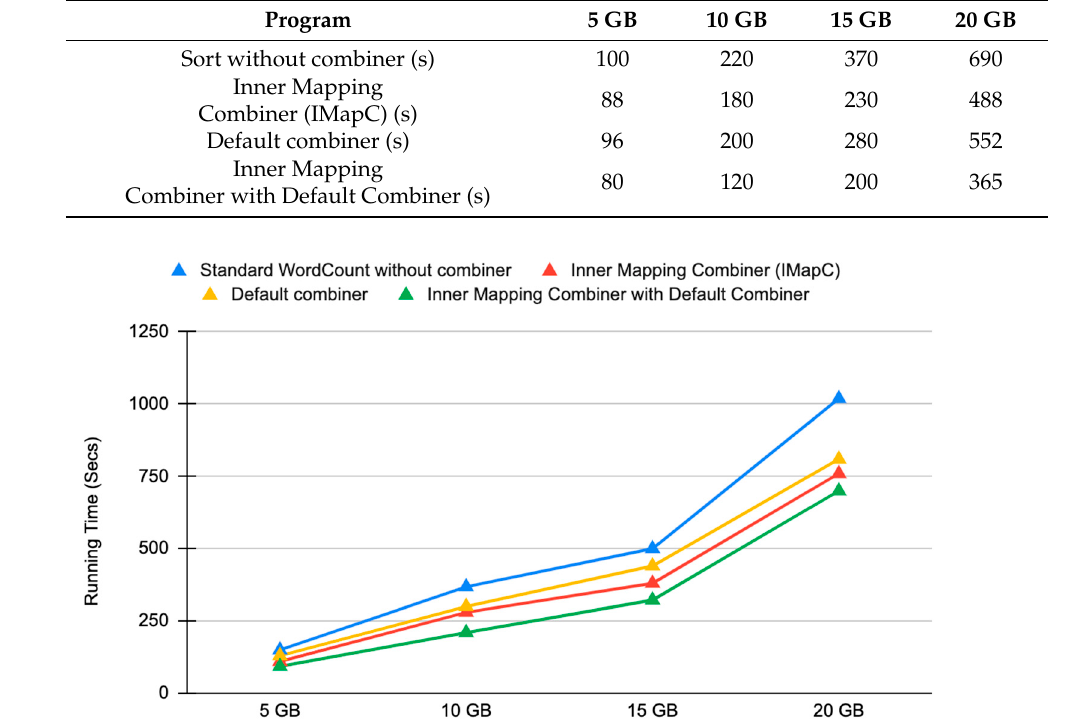
Figure 8. The execution time of WordCount program comparing TFR, TFR with IMapC, and Ha- doop.